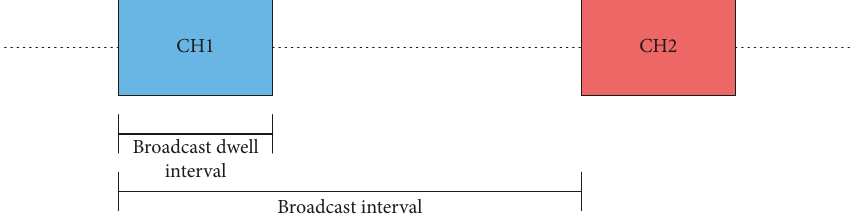
Figure 2: An example broadcast FH sequence.